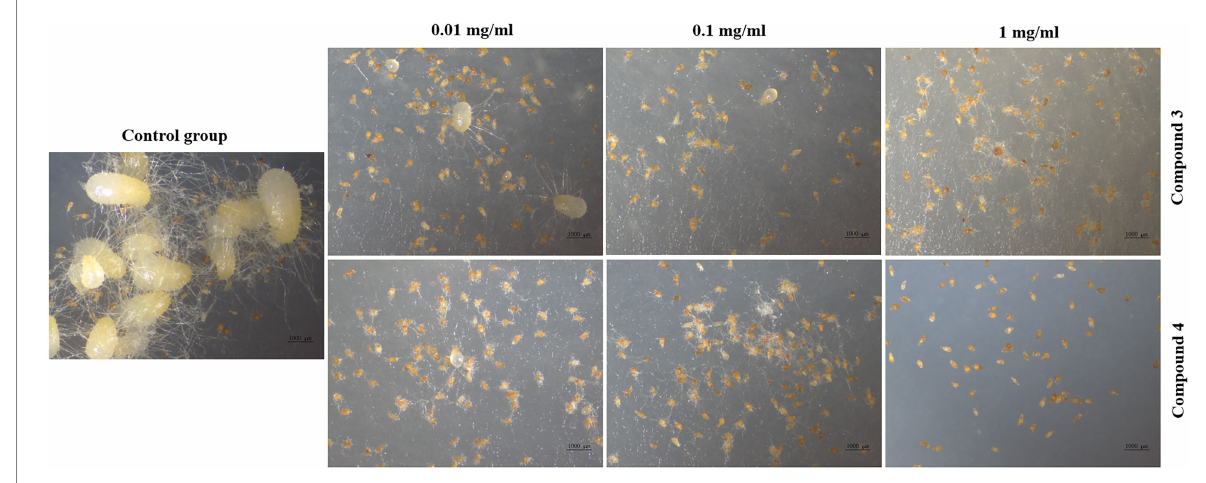
FIGURE 9 Inhibitory effects of 3 and 4 on seed germination of G. conopsea